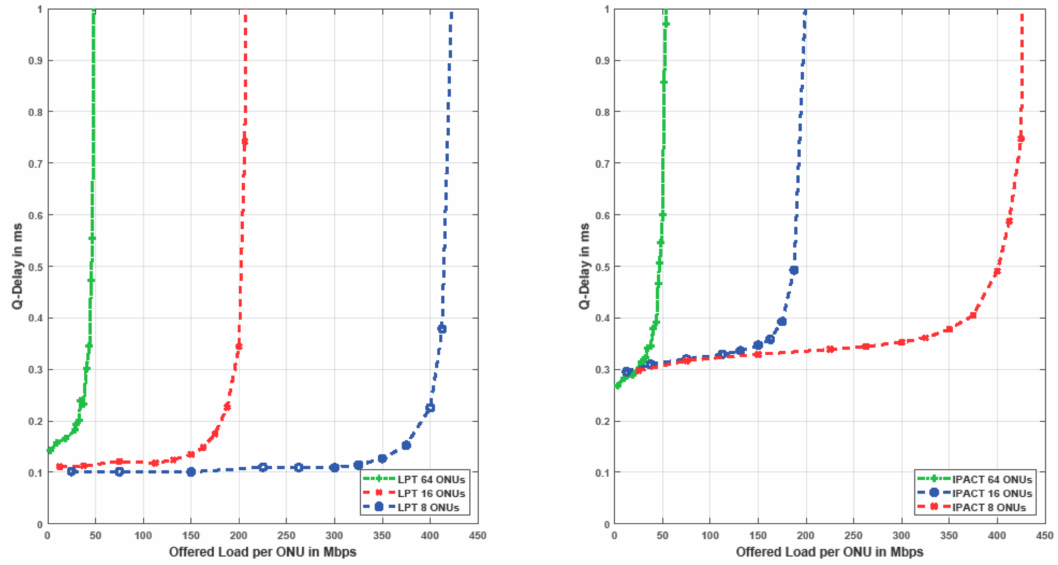
Figure 9. Average queue delay for all ONUs at LTT = 10 µ s for 64 ONUs, 16 ONUs and 8 ONUs; LPT ( left ) and IPACT ( right